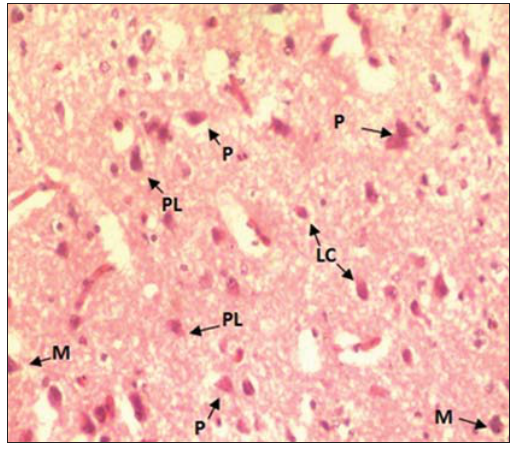
Figure-5: Cross section of hippocampus (H & E ×400) showing different types of neurons. (P) Pyramidal, (M) Multipolar, (PL) Pyramidal like cells, (LC) Local circuit neuron).